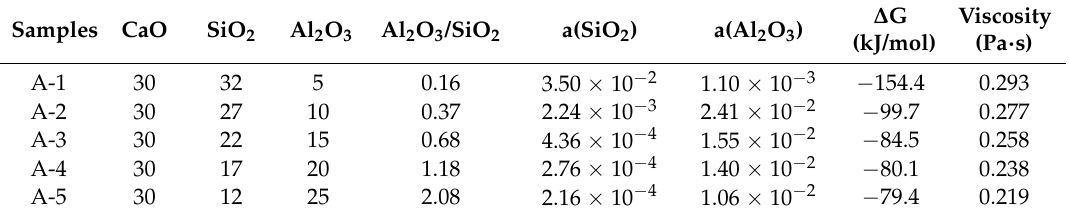
Table 4. The mold flux for high aluminum steel with different Al 2 O 3 /SiO 2 ratios. Samples